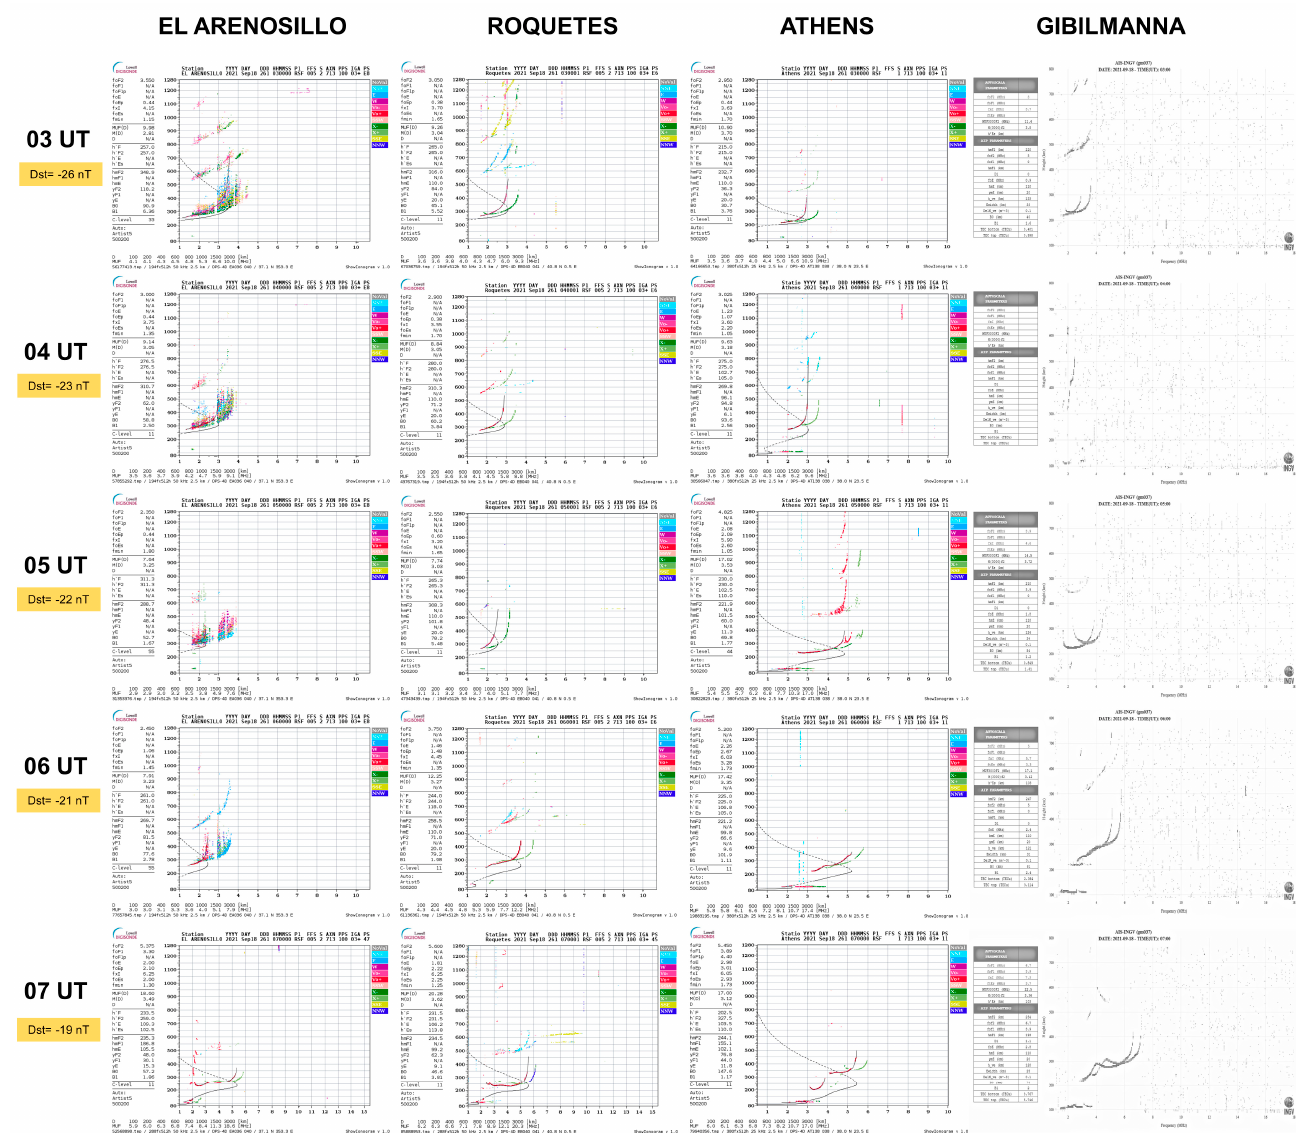
Figure 4. Ionograms (height in km vs. frequency in MHz) every 1 h from different ionosondes: El Arenosillo (first column), Roquetes (second column), Athens (third column) and Gibilmanna (fourth column), during the main phase of the 17–18 September 2021 geomagnetic storm. Legends on the left side indicate the automatically scaled parameters of the ionograms. In El Arenosillo, Roquetes and Athens ionograms, information about MUF for oblique propagation to a corresponding range is provided in the bottom part. Colours indicate directions of the ionospheric returns and Doppler shift of overhead ordinary and extraordinary ionospheric returns. In the top part, information about the ionosonde and the date and time of the ionogram can be found in the four columns for each ionogram. Although in this work the scaled parameters of the ionograms are not analysed, we have preferred to maintain this information because ionograms are directly provided by the DIDbase web portal from GIRO and the eSWua web portal from INGV.